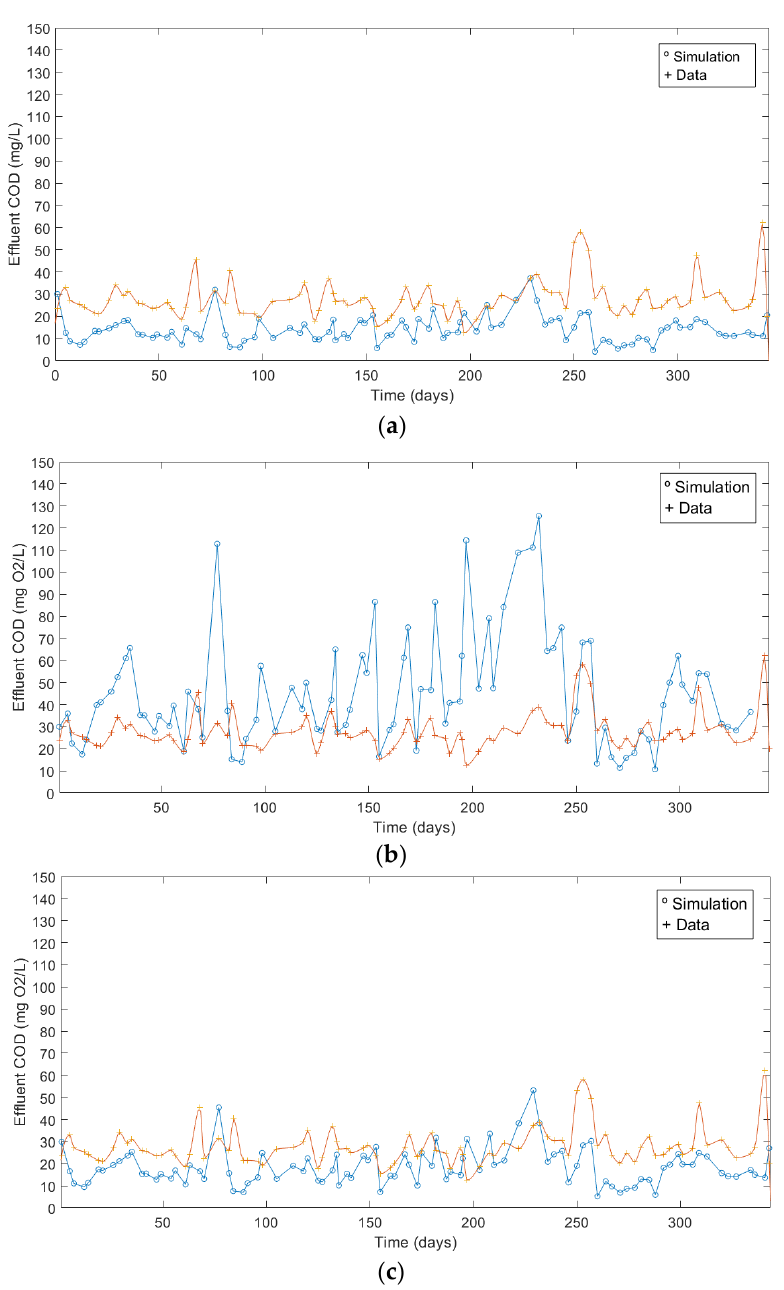
Figure 4. Tuning on μ H , max for Y H = 0.6. ( a ) μ H , max = 0.6 d −1 , ( b ) μ H , max = 0.3 d −1 and ( c ) μ H , max = 0.5 d −1 . Simulation is the blue line and analysed data is the orange line.